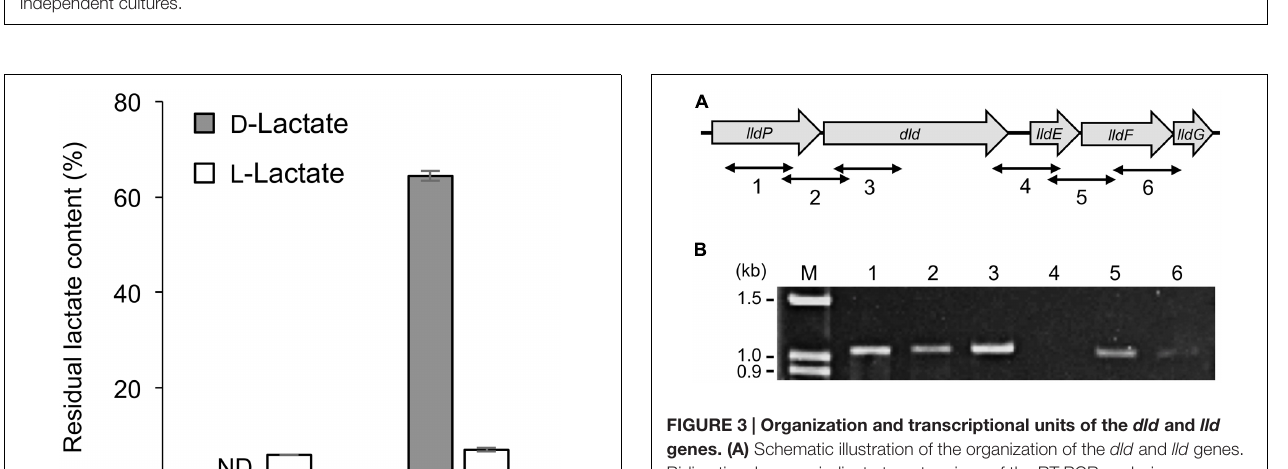
FIGURE 1 | Growth of wild-type (WT) and (cid:49) crp on DL -lactate (A) , D -lactate (B) , L -lactate (C) , and pyruvate (D) . WT (closed circle) and (cid:49) crp (open circle) were aerobically grown in minimal medium (MM) containing 10 mM of each substrate. Error bars represent standard deviations calculated from at least triplicate independent cultures.